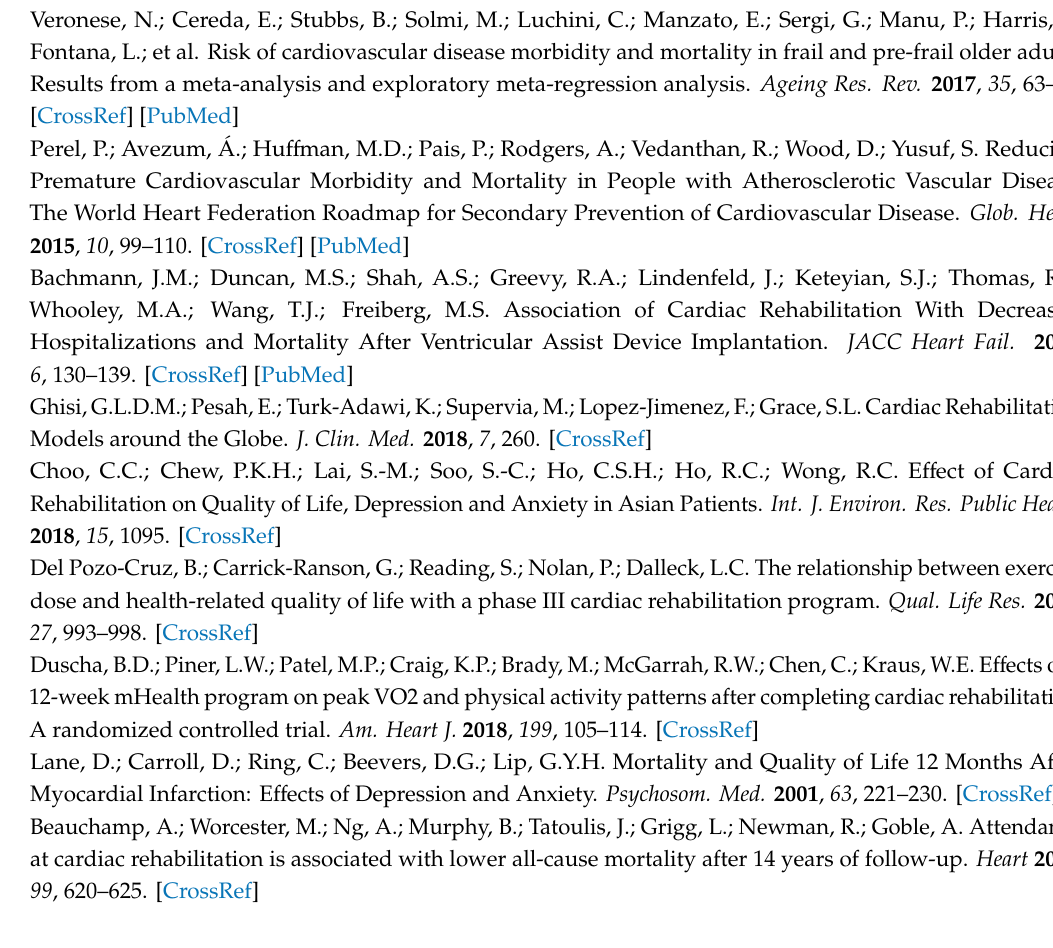
Figure S1: Scree plot indicating the amount of variance explained by each principal component. Figure S2: Receiver-operating characteristic (ROC) curves for the artificial neural network. Table S1: Di ff erence between before and after cardiac rehabilitation according to three status